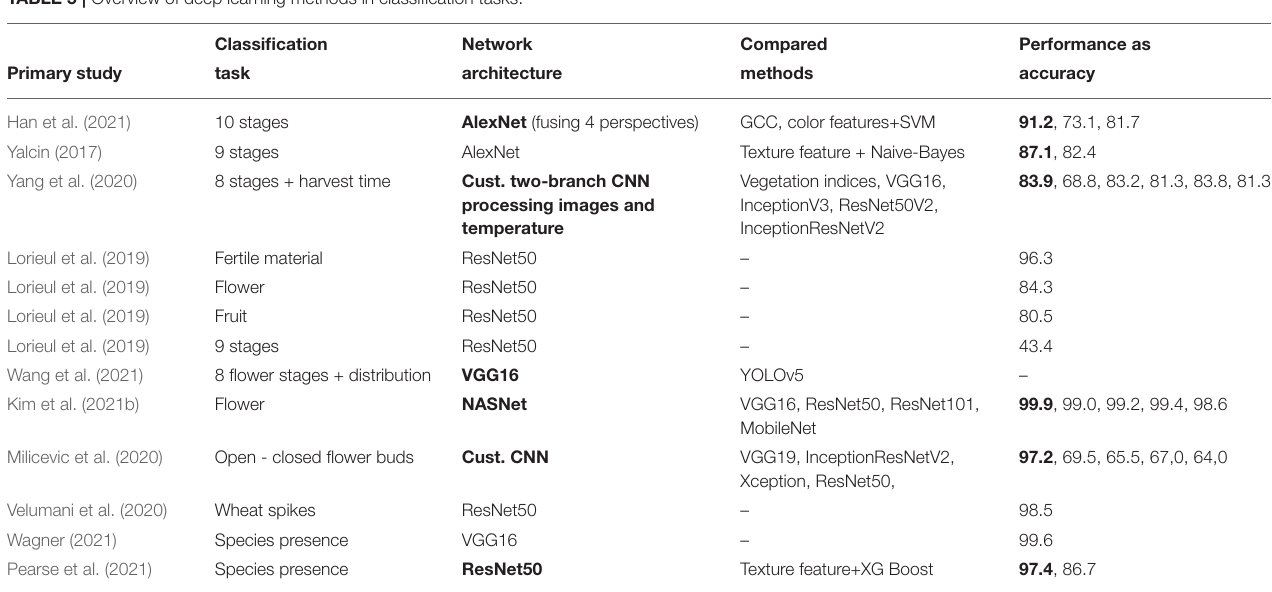
TABLE 5 | Overview of deep learning methods in classification